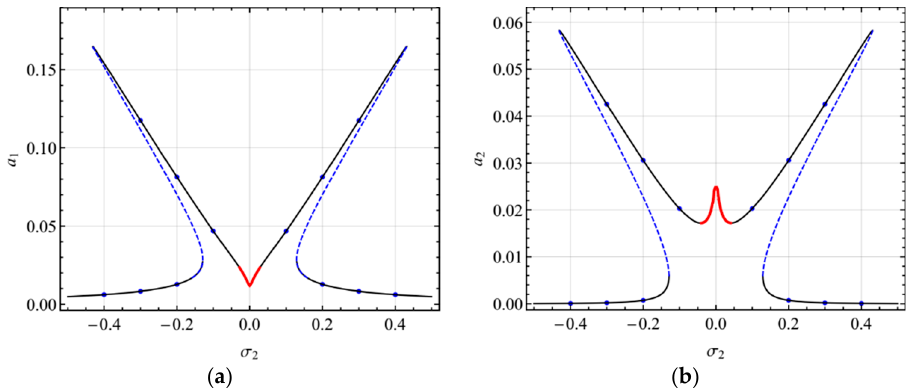
Figure 11. Comparison of the frequency-response curves of the primary resonance of the first mode;